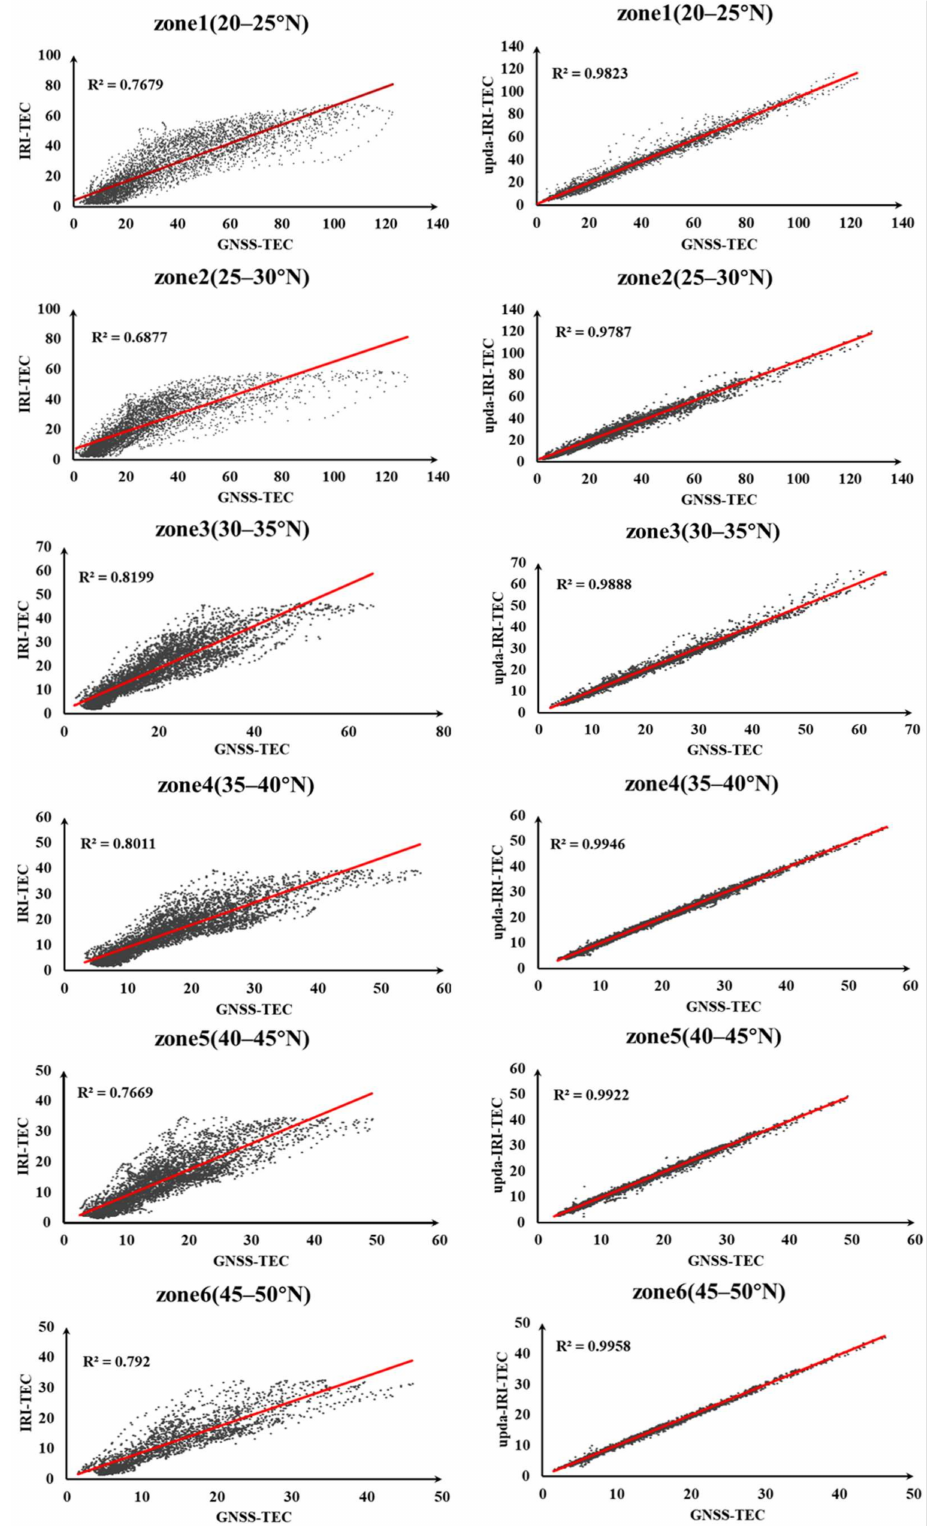
Figure 9. Linear regression diagrams between GNSS-TEC data from 2015 and the corresponding results of IRI-2016 and upda-IRI-2016 for 12 stations divided by